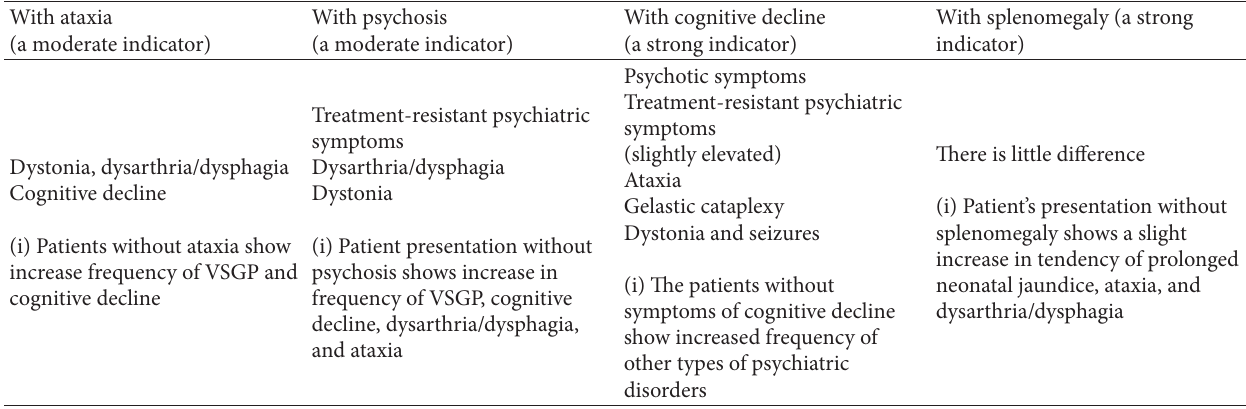
Table 4: Association of manifestations by the presence and absence of leading NP-C manifestations (ataxia, cognitive decline, psychosis, and splenomegaly) at age > 4 years